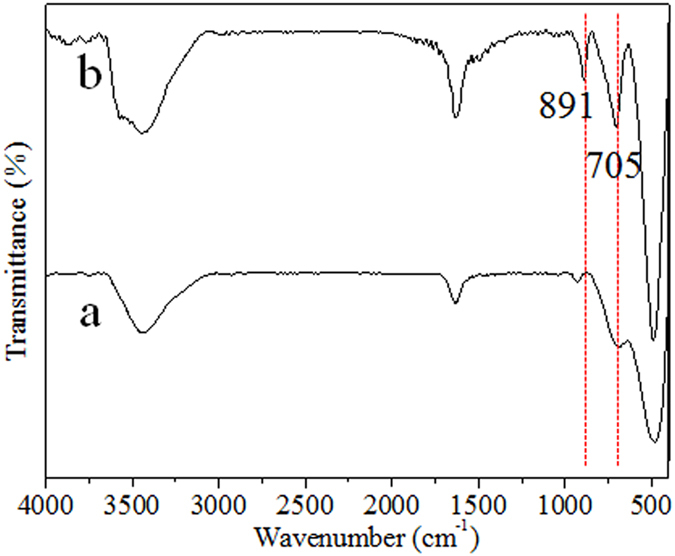
FTIR spectrums of the HTO crystals (a) before and (b) after the treatment in H2O2 solution, respectively.